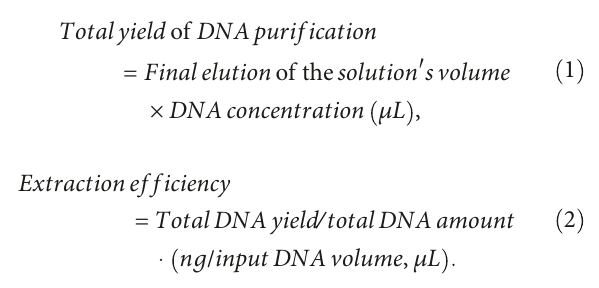
O composite, with that of pure 3 4